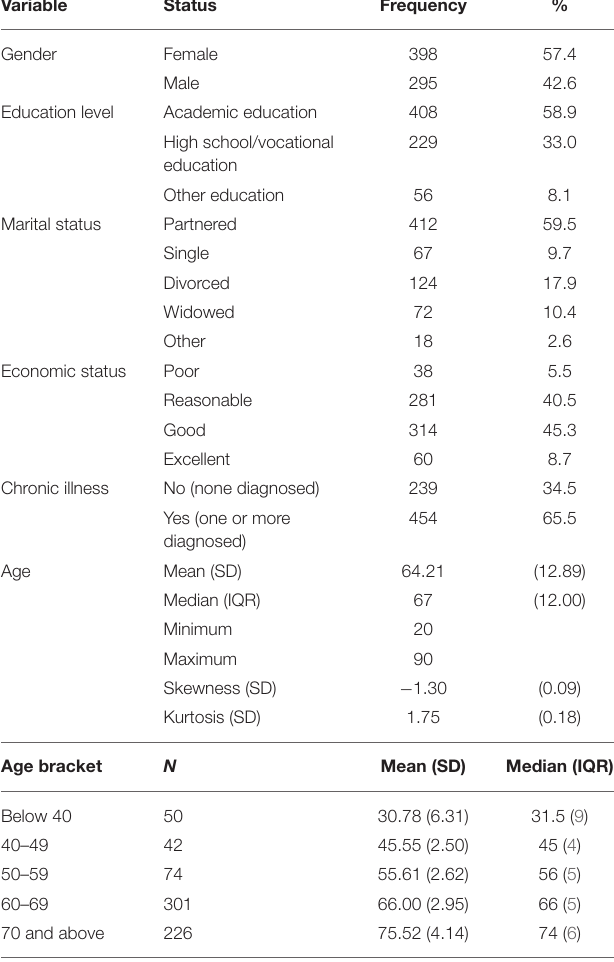
TABLE 1 | Descriptive statistics of the sample ( N =